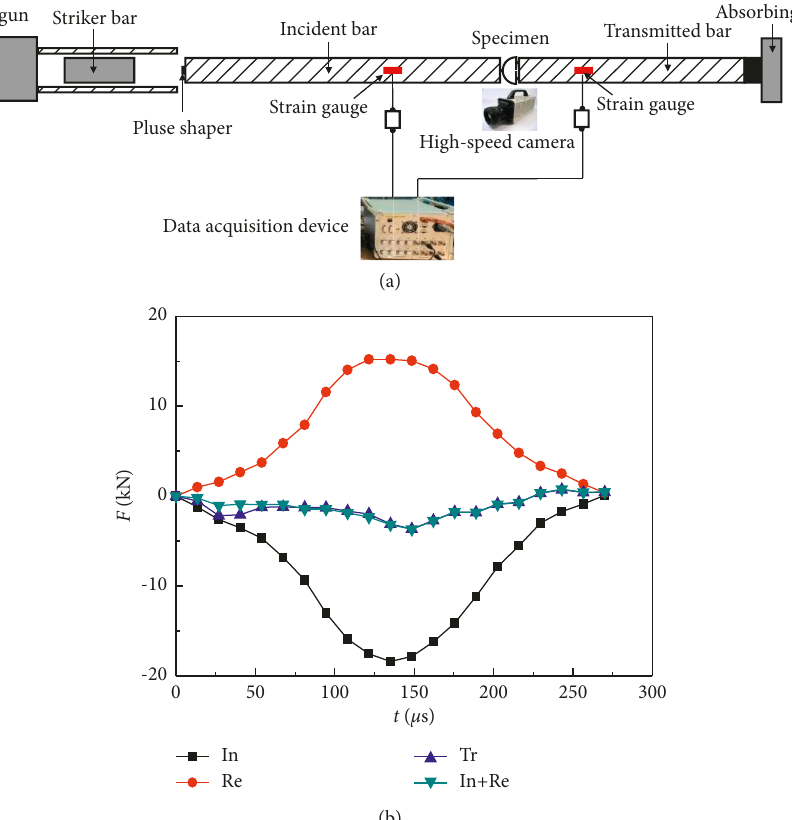
Figure 2: (a) Schematic of split Hopkinson pressure bar (SHPB) system, (b) dynamic force balance